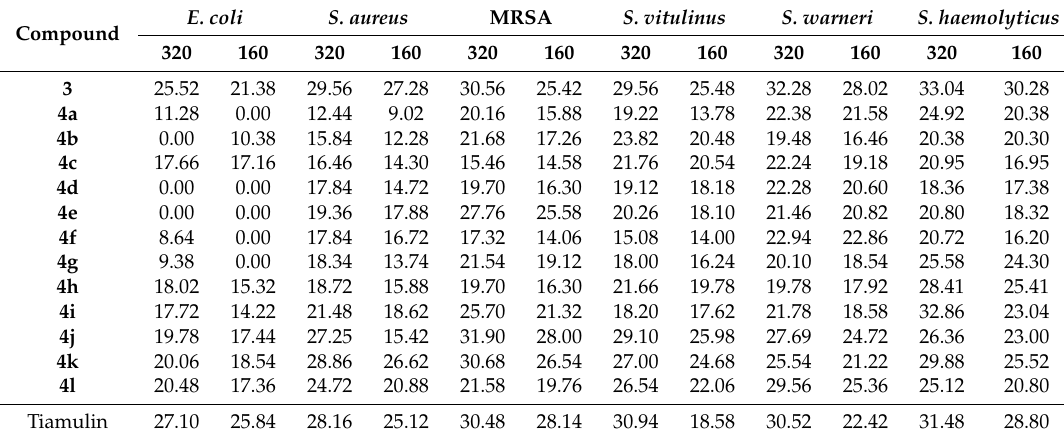
Table 2. Zone of inhibition for E. coli , S. aureus , MRSA, S. vitulinus , S. warneri , and S. haemolyticus in mm. Compound